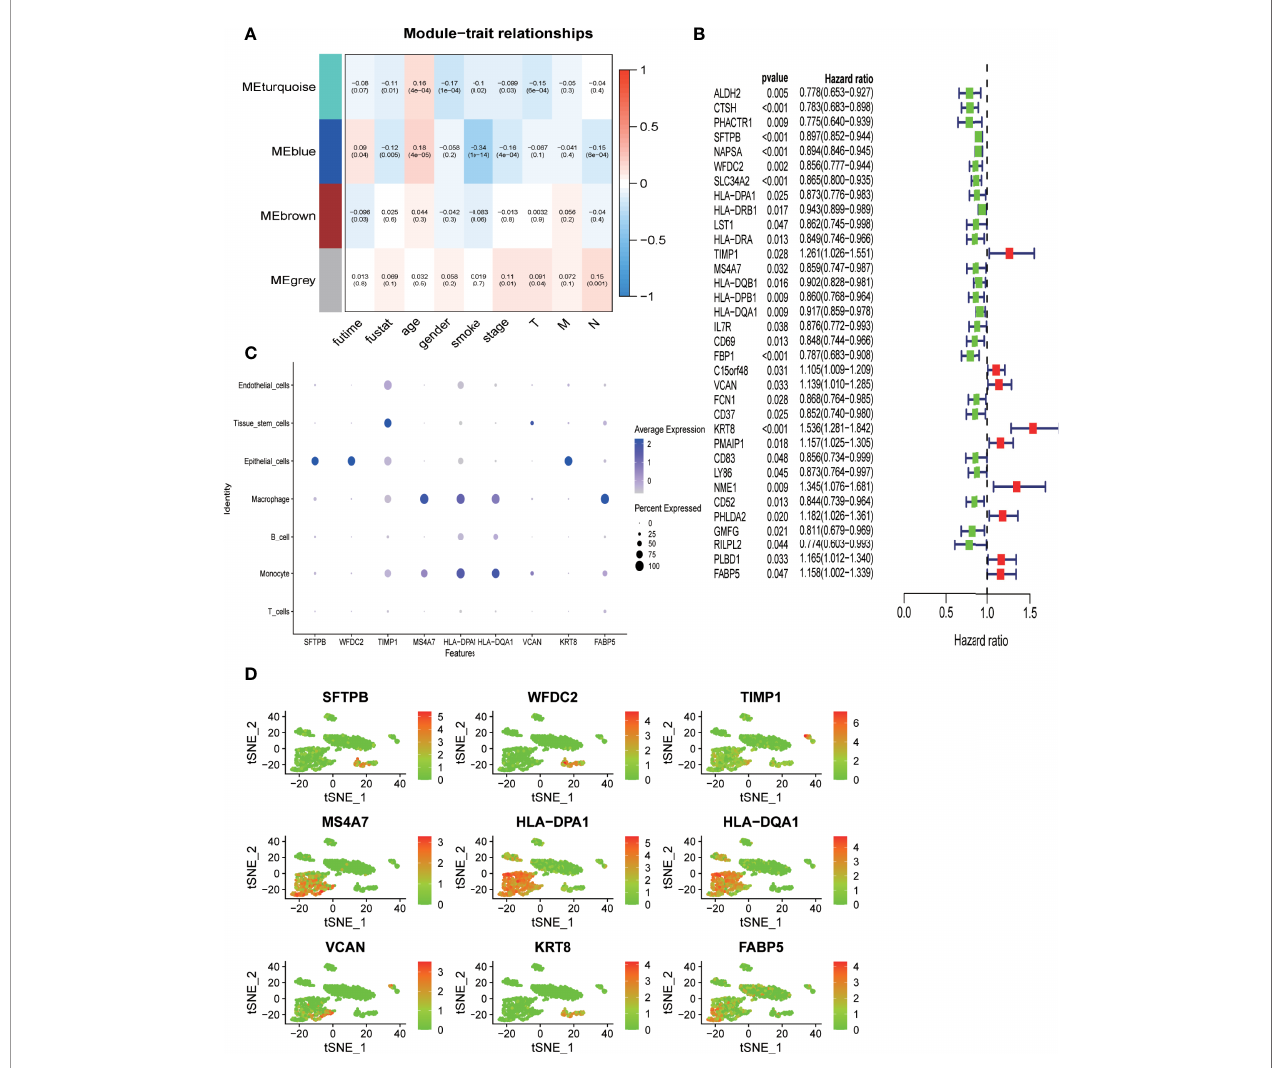
FIGURE 5 | Deidenti fi cation of hub-DRGs for the prognostic model (RiskScore) (A) Heatmap showing the correlation between modules of DRGs derived from WGCNA analysis and clinical traits such as age, sex, smoking status, TNM stages, survival time, and survival status in TCGA-LUAD cohort. The correlation coef fi cient and p value (in parentheses) are shown. (B) Forest plot demonstrating DRGs with signi fi cant prognostic impact in TCGA-LUAD cohort. Genes were converted into dichotomous variable with median value as the cutoff level; subsequently, logistic regression univariate analysis was conducted to explore their correlation with overall survival. Genes associated with favorable survival are denoted in green in the forest plot, while those associated with unfavorable prognosis are denoted in red. (C, D) . Expression level of the nine hub genes across different cell types in nine clusters as classi fi ed by the tSNE